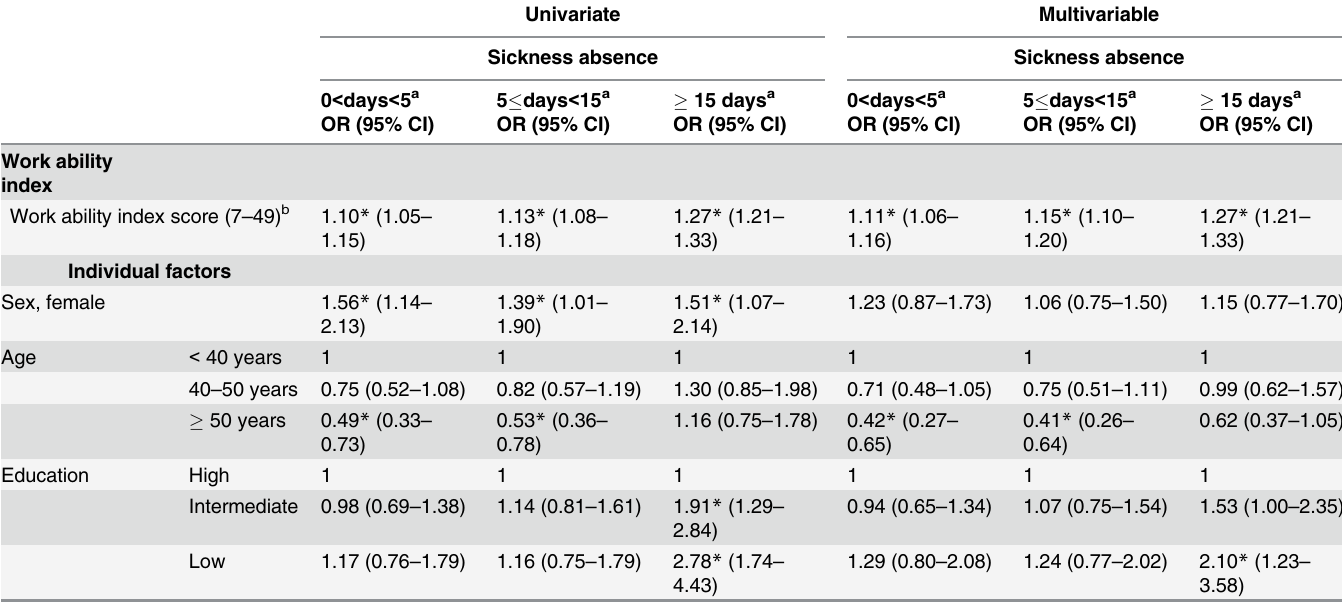
Table 2. Univariate and multivariable multinomial regression analyses with odds ratios and 95% confidence intervals for the association between work ability, and individual factors with sickness absence among office workers (n = 1,331).